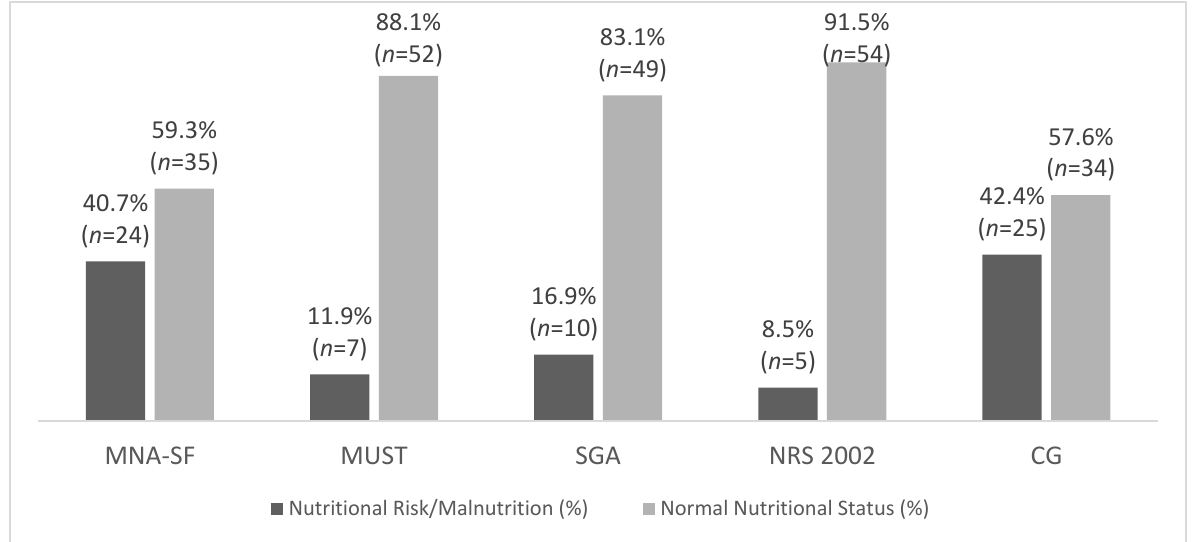
Figure 3. Percentage mean value obtained from each nutritional assessment and screening tool in the institutionalize pop- ulation (MNA-SF—Mini Nutritional Assessment Short Form; MUST—Malnutrition Universal Screening Tool; SGA—Sub- jective Global Assessment; NRS 2002—Nutritional Risk Screening 2002; CG—calf girth).